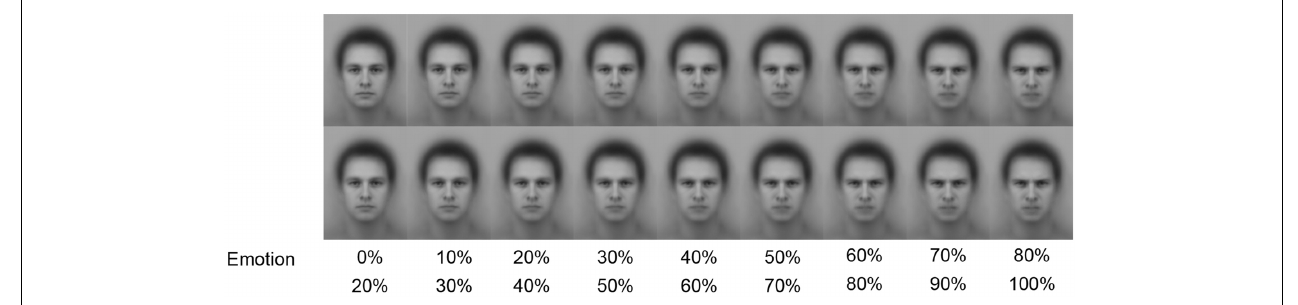
FIGURE 2 | Examples of face pairs used in the categorical perception task (presented vertically). At study, the faces in each pair were presented side by side.